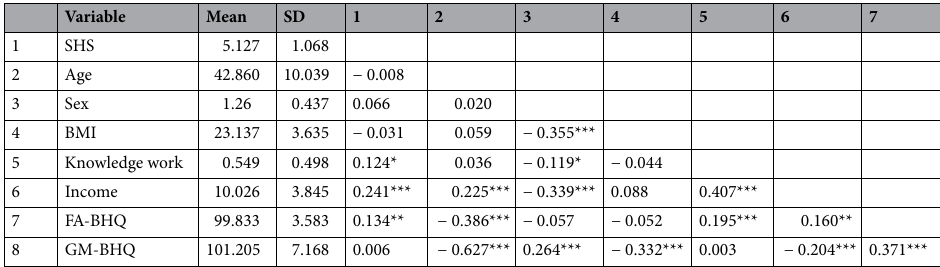
Table 2. Descriptive statistics and correlations. n = 417; *p < 0.05; **p < 0.01; ***p <